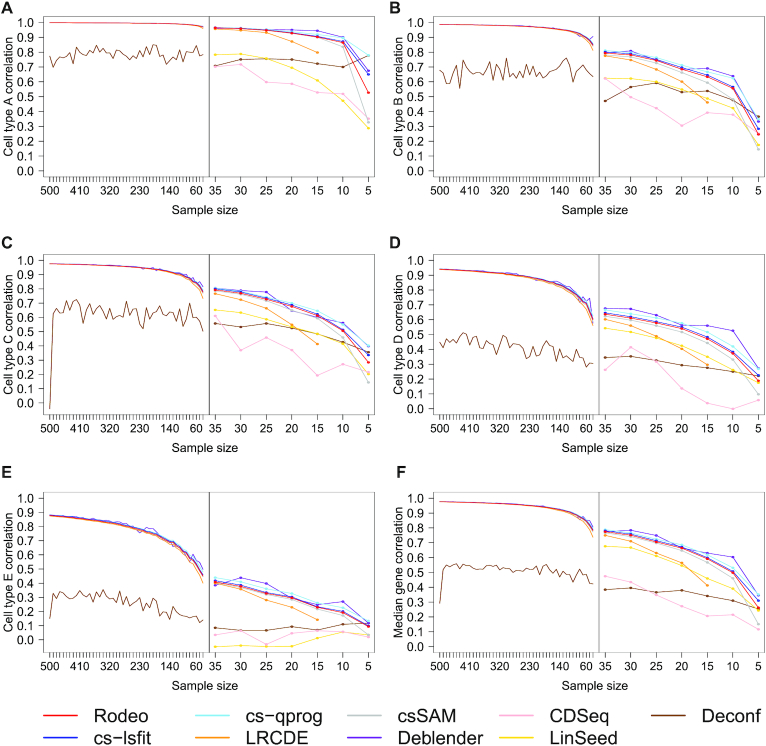
Effect of sample size to the correlation between known and estimated csGEPs (subfigures A–E) and to median gene correlation (subfigure F). Pearson correlation (y-axis) is shown at different sample sizes (x-axis). The left-hand side of each subfigure provides an overview of large sample sizes 40–500, and the right-hand side illustrates smaller sample sizes 5–35 in a more targeted manner. At each sample size, 50, or 20 for Deblender and CDSeq, random subsets of samples were generated and median accuracies are shown here.